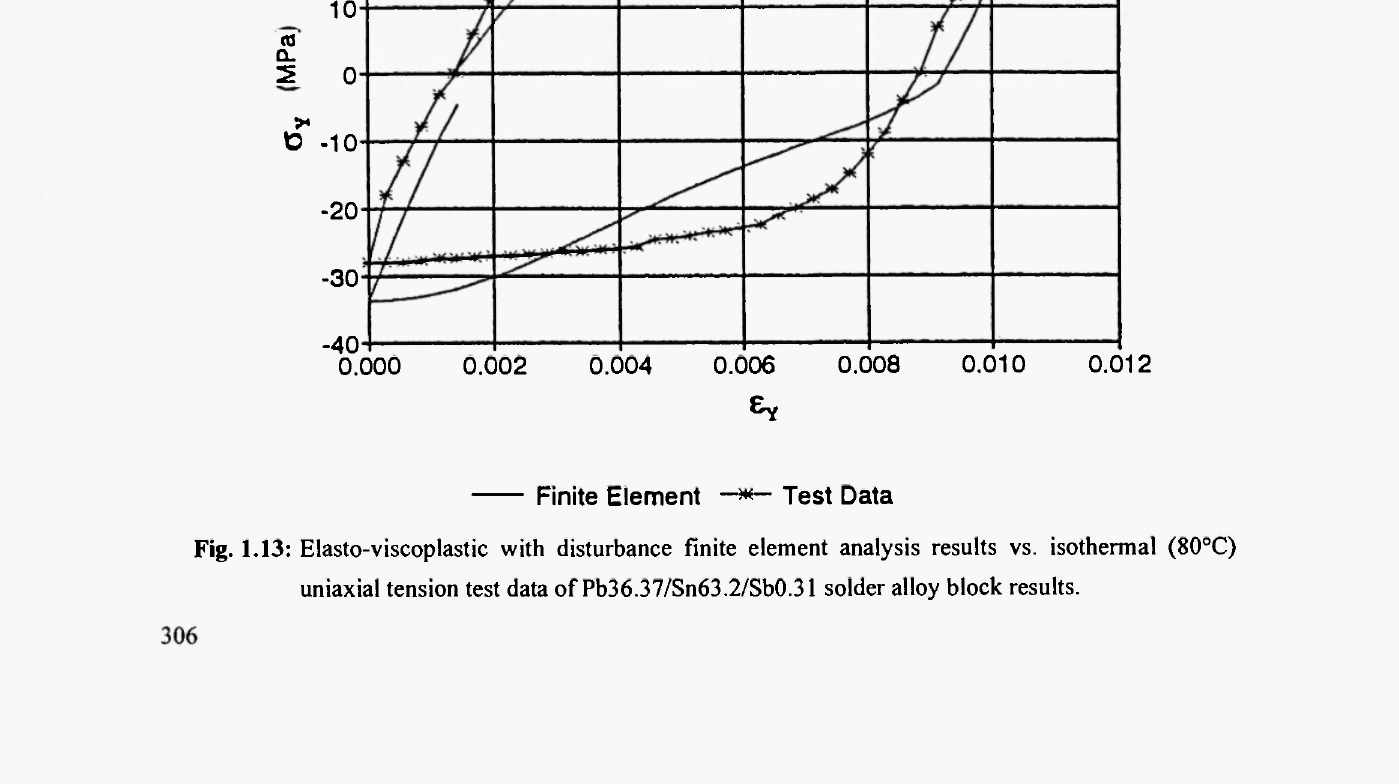
Fig. 1.13: Elasto-viscoplastic with disturbance finite element analysis results vs. isothermal (80 °C) uniaxial tension test data of Pb36.37/Sn63.2/Sb0.31 solder alloy block